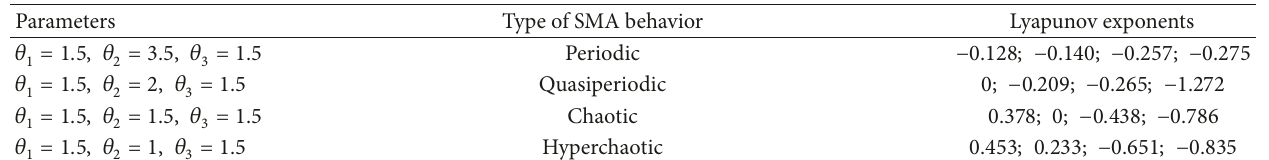
Table 2: Types of fractional order 2DOF SMA behavior.